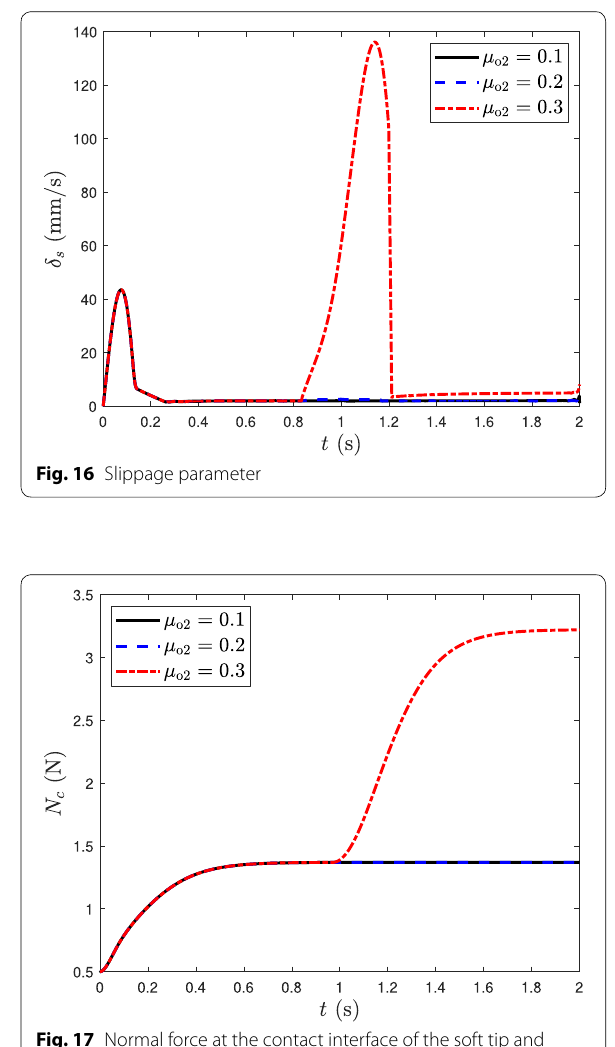
(Fig. 17) and moves the object on the predefined desired path. When the object reaches the region with µ o2 = 0.2 ,